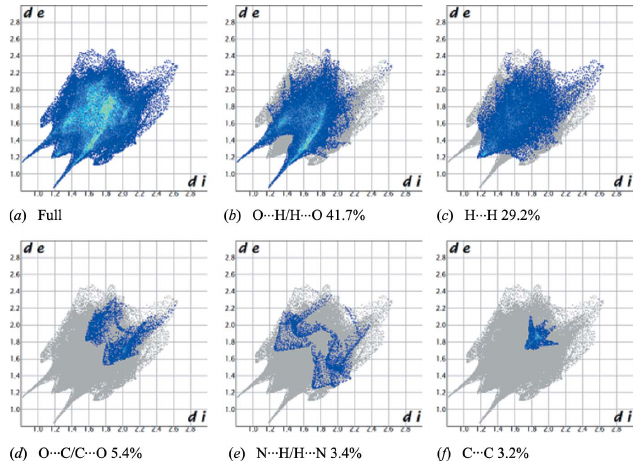
Figure 6 Two-dimensional fingerprint plots for the title compound showing the contributions of different types of